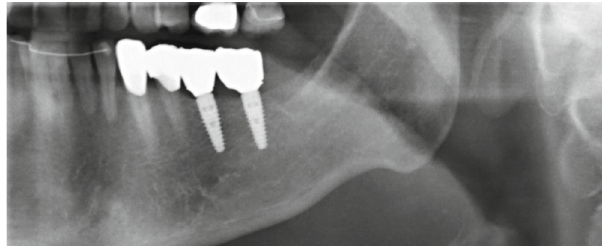
Figure 18: X-ray check at the crown fi tting.